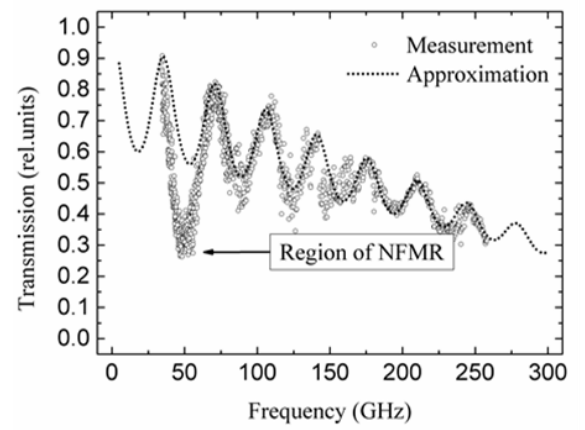
Fig. 2. Frequency dependence of the transmission coefficient of composite based on 60 wt.% BaFe 12 O 19 ferrite and ABS plastic matrix.